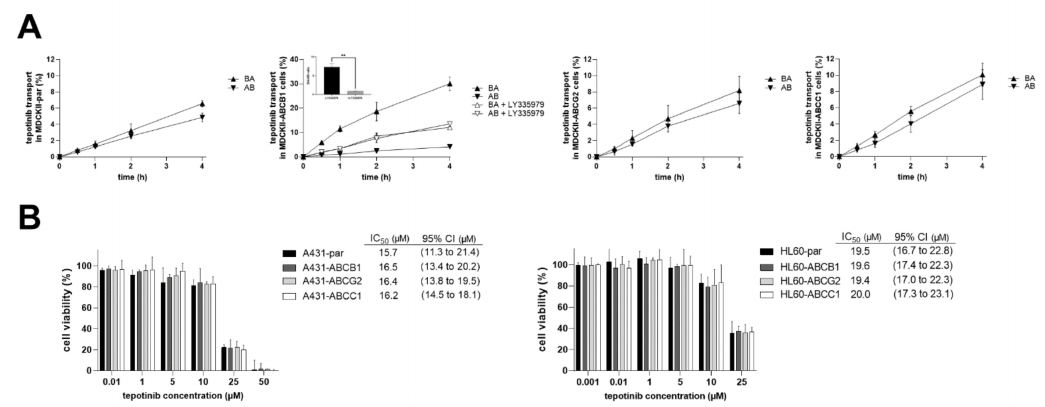
Figure 7. ( A ) Monolayer transport studies for 1 µ M tepotinib in MDCKII cells. BA/AB ratio was calculated by dividing the percentage of tepotinib transported in basal-to-apical (BA) direction by that in apical-to-basal (AB) direction 4 h after drug’s addition. 100% control transport value was represented by the 1 µ M solution of tepotinib from the same dilution, which was used for all tested variants. ( B ) Comparative viability studies in A431 and HL60 cells. Treatments with vehicle- containing media and 40% DMSO in media were used as 100% and 0% viability controls for data normalization, respectively. IC 50 values from transporter-expressing cells were compared with those from parent cells, but no statistically significant differences were observed for any variant.